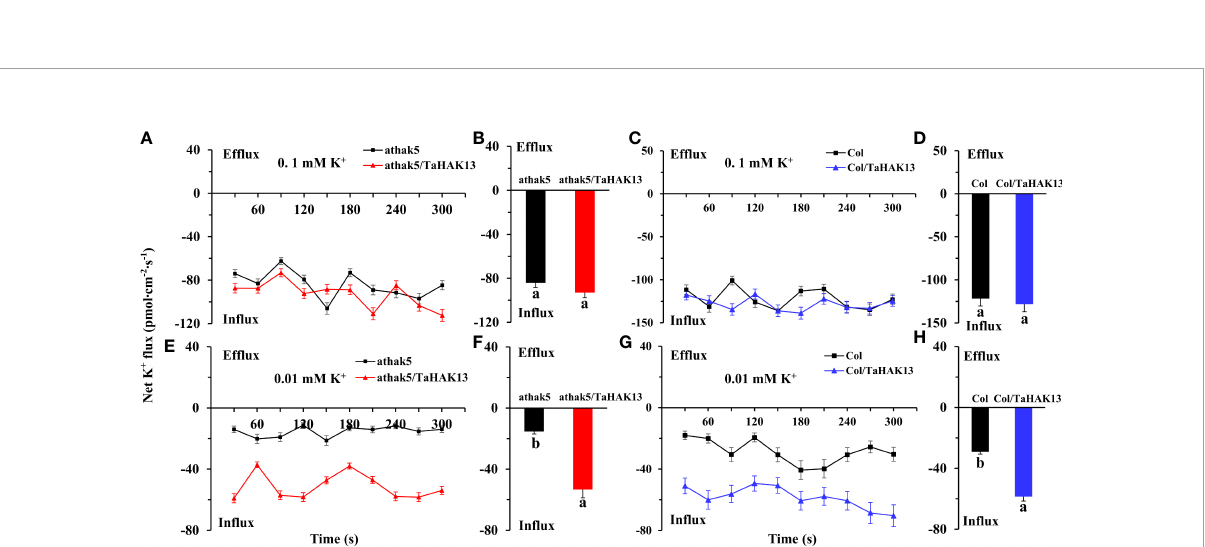
FIGURE 8 Effect of TaHAK13 expression on the net K in fl ux in primary root meristem supplied with different concentrations of (K) (A, C) The net K in fl ux of Arabidopsis thaliana mutant athak5 and its complementary line ( athak5 / TaHAK13 ) over 8 min (see ‘ Materials and methods ’ ). (B, D) Mean net K in fl ux of athak5 and athak5 / TaHAK13 when 0.1 mM K + (A) or 0.01 mM K + (C) was supplied; average values were taken over the whole eight minutes of in fl ux data. (E, G) The net K in fl ux of wild-type Arabidopsis thaliana (Col) and its overexpression line (Col/ TaHAK13 ) over 8 min. (F, H) Mean net K in fl ux of Col and Col/ TaHAK13 when 0.1 mM K + (A) or 0.01 mM K + (C) was supplied; average values were taken over the whole eight minutes of in fl ux data. Signi fi cant differences between transgenic lines and their respective non-transgenic lines are indicated by different